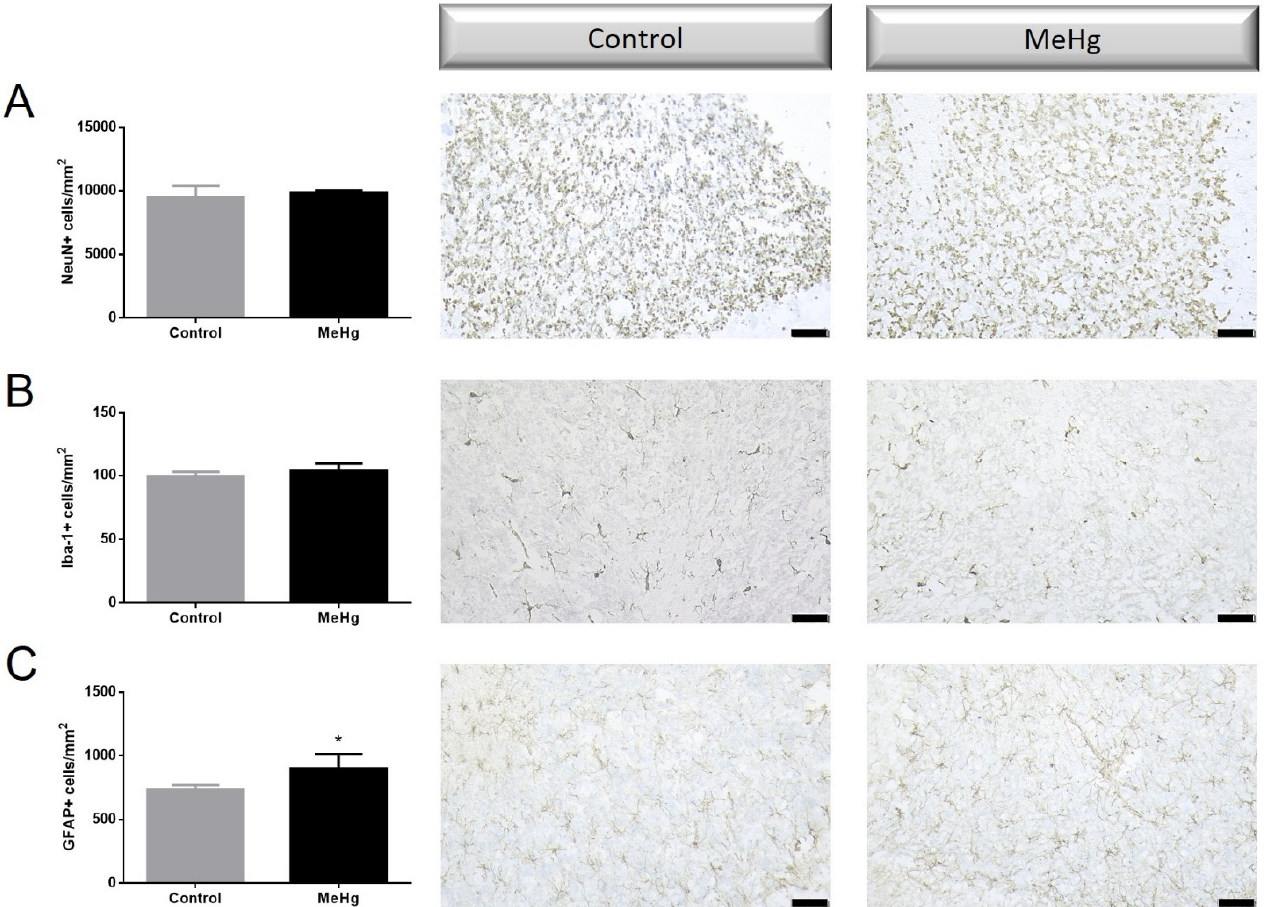
Figure 2. Effects of methylmercury (MeHg) in neurons, microglia and astrocytes in cerebellum. Quantitation of immunostaining cells (graphics on the left) and representative photomicrographs (center and right) of the cerebellum of rats orally exposed to water (Control) or MeHg 5 mg/kg (MeHg) for four consecutive days: ( A ) neurons (positive cells for NeuN marker, NeuN+); ( B ) microglial cells (positive for Iba-1 marker, Iba-1+); and ( C ) astrocytes (positive cells for GFAP marker, GFAP+). Immunohistochemistry was performed 24 h after the last dose of treatment. Results are expressed as mean ± SEM. n = 3–4 per group. Student t test, * p < 0.05 vs. control. Scale bar = 50 µm.